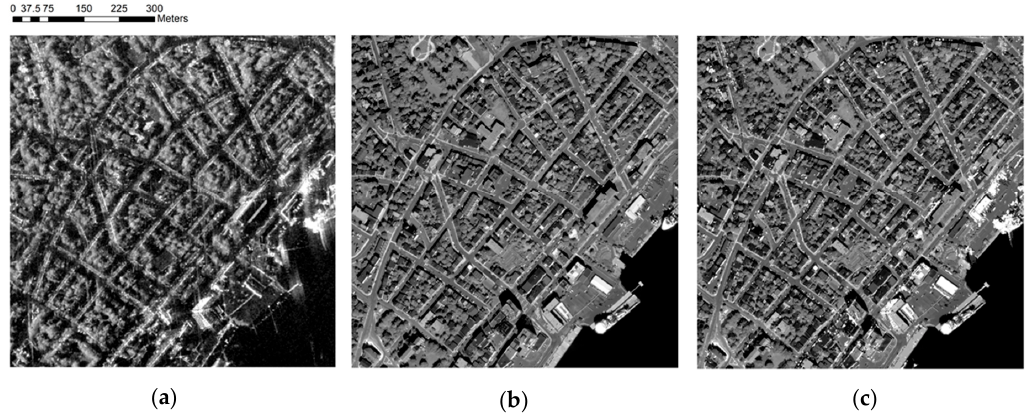
Figure 12. Experimental images in the additional dataset (Site 1): ( a ) TerraSAR-X image acquired on 8 August 2019, ( b ) GeoEye-1 image acquired on 19 August 2019, ( c ) fusion result of the proposed method.